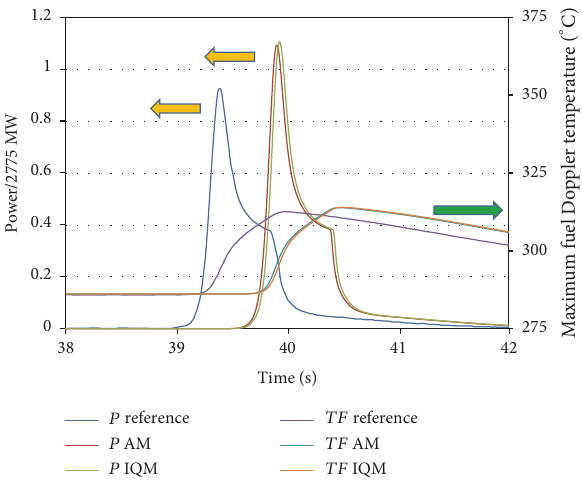
Figure 5: Fission power ( 𝑃 ) and average core Doppler temperature ( 𝑇 𝐹 ) distributions for Case D.